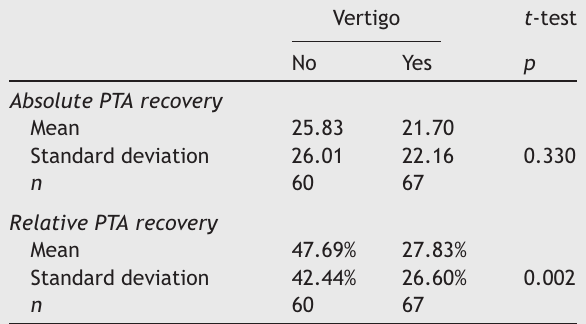
Independent Student’s t -tests between presence